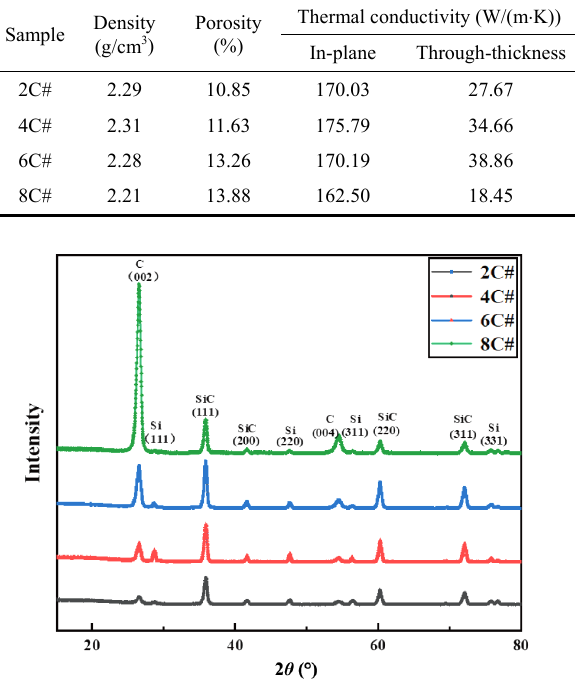
Fig. 11 XRD patterns of C pf /SiC composites prepared with different resin carbon contents.